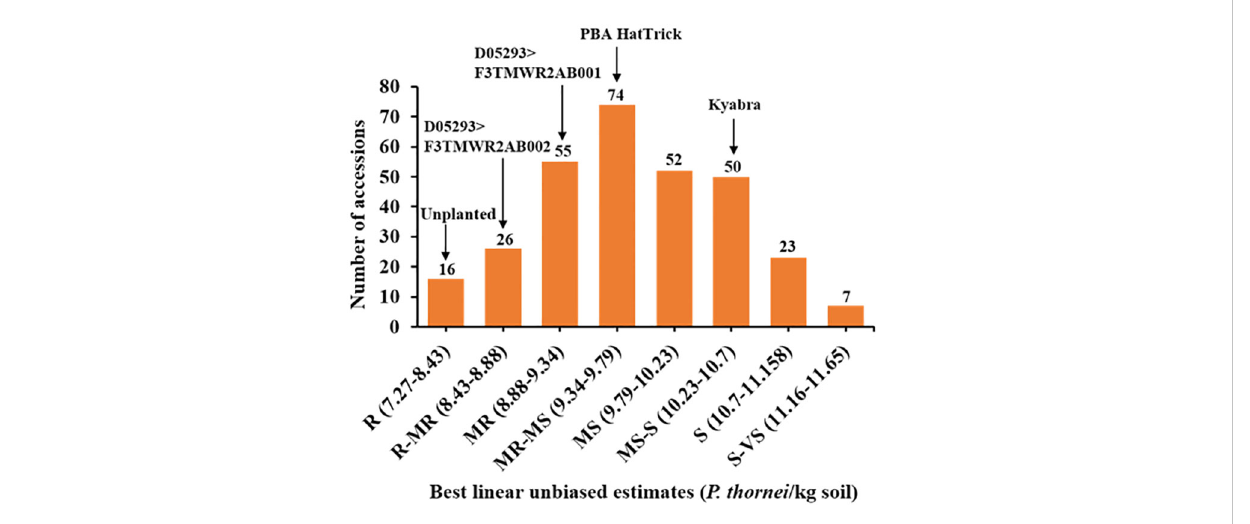
FIGURE 1 Frequency distribution histogram of the chickpea reference collection and additional resistance sources (total 303 accessions) for P. thornei population densities. Data shown is the best linear unbiased estimate (BLUE) values for combined analysis of Experiment 1 and Experiment 2. Resistant (R), resistant to moderately resistant (R-MR), moderately resistant (MR), moderately resistant to moderately susceptible (MR-MS), moderately susceptible (MS), moderately susceptible to susceptible (MS-S), susceptible (S), susceptible to very susceptible